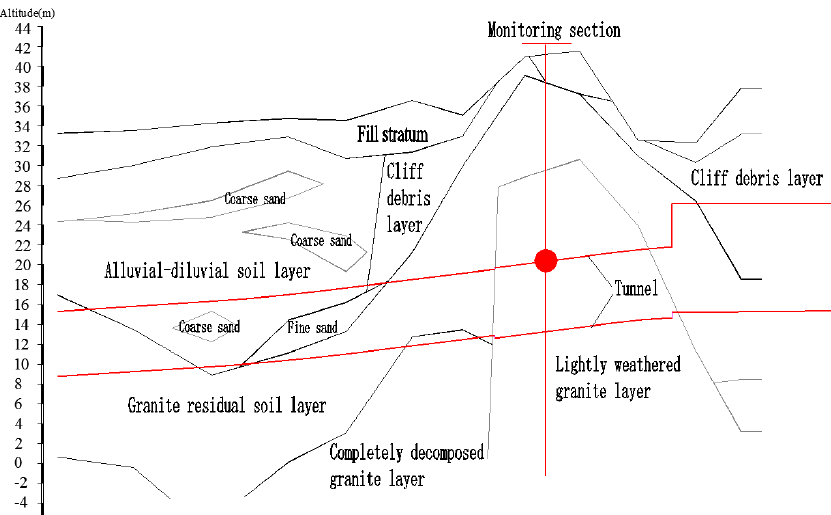
Figure 7. Vertical section of the monitoring point.